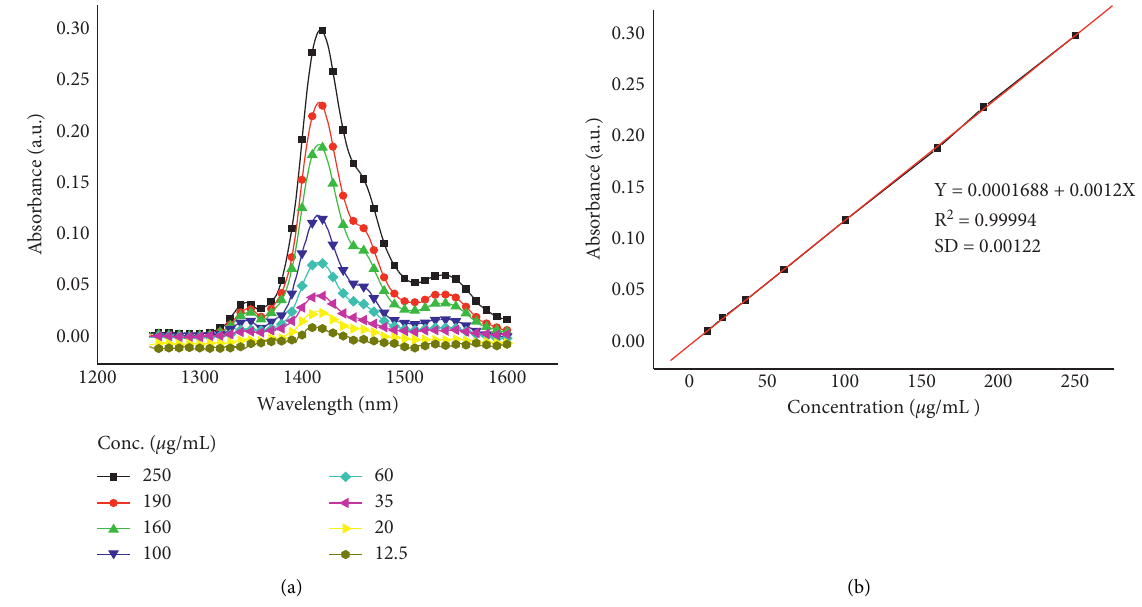
Figure 7: NIR spectra of different standard concentrations of β -carotene (a) and calibration curve (b). Table 2: Content ( µ g/g) of β -carotene from the three parts of pumpkin (peel, flesh, and seed) samples using the NIR spectroscopic method. Sample